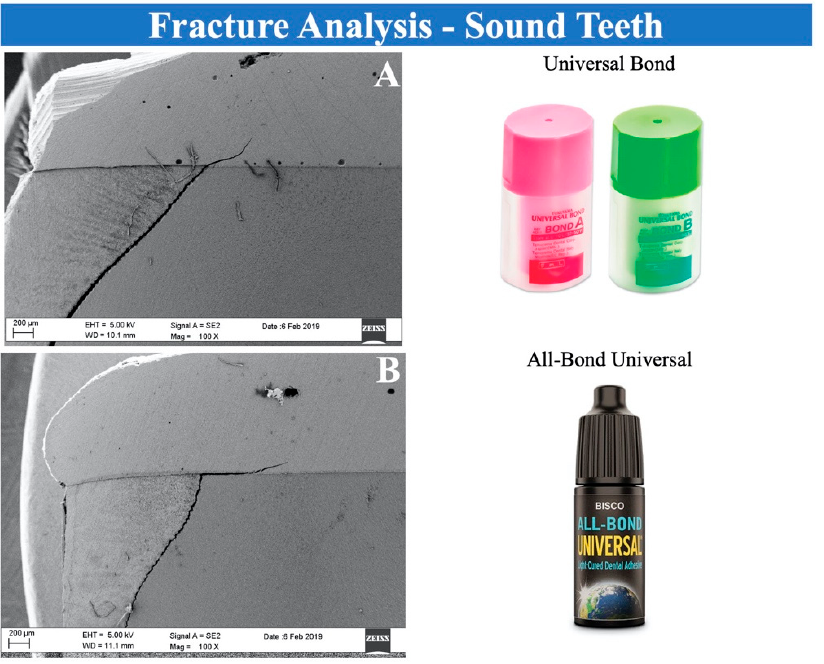
Figure 2. SEM images of fractures in samples with Universal Bond ( A ) and All-Bond Universal ( B ) on sound tooth. The fractures depicted occurred during sample processing for SEM due to dehydration; this occurs due to the different content of water between enamel and dentin causing the dentin to shrink and separate from enamel. The way the fracture ends in the composite mass indicates that bonding between dentin and composite is equal or stronger than the natural bonding between enamel and dentin.